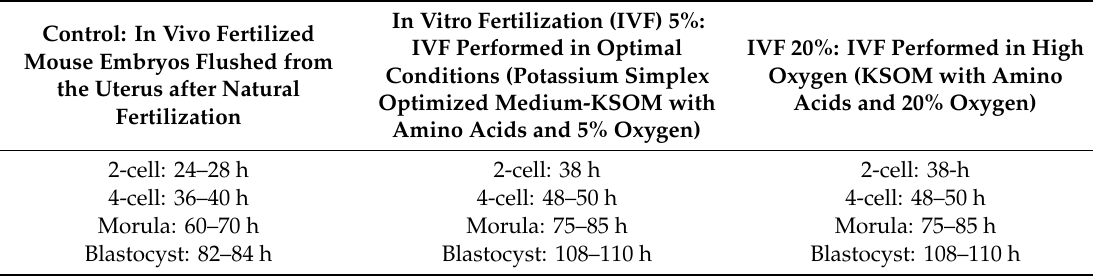
Table 1. Schematic representation of the experimental